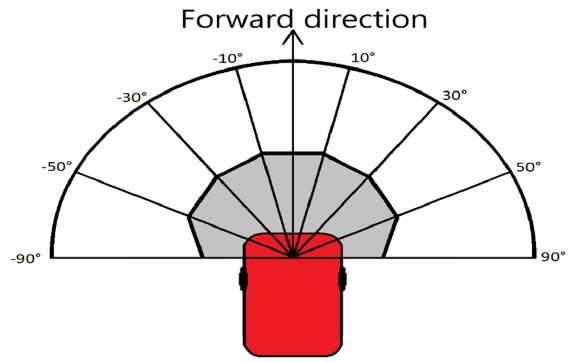
Figure 16. Detection area of the sonars and the sensitivity bubble.